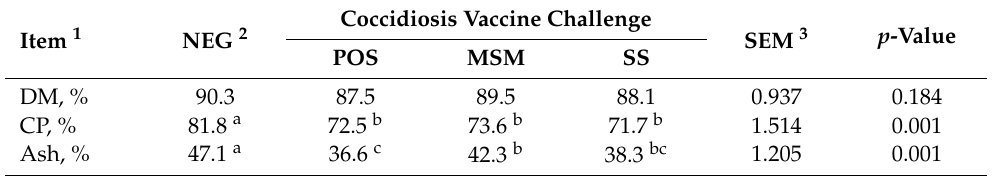
Table 8. Effect of dietary sulfur sources on the apparent ileal digestibility of nutrients in broiler